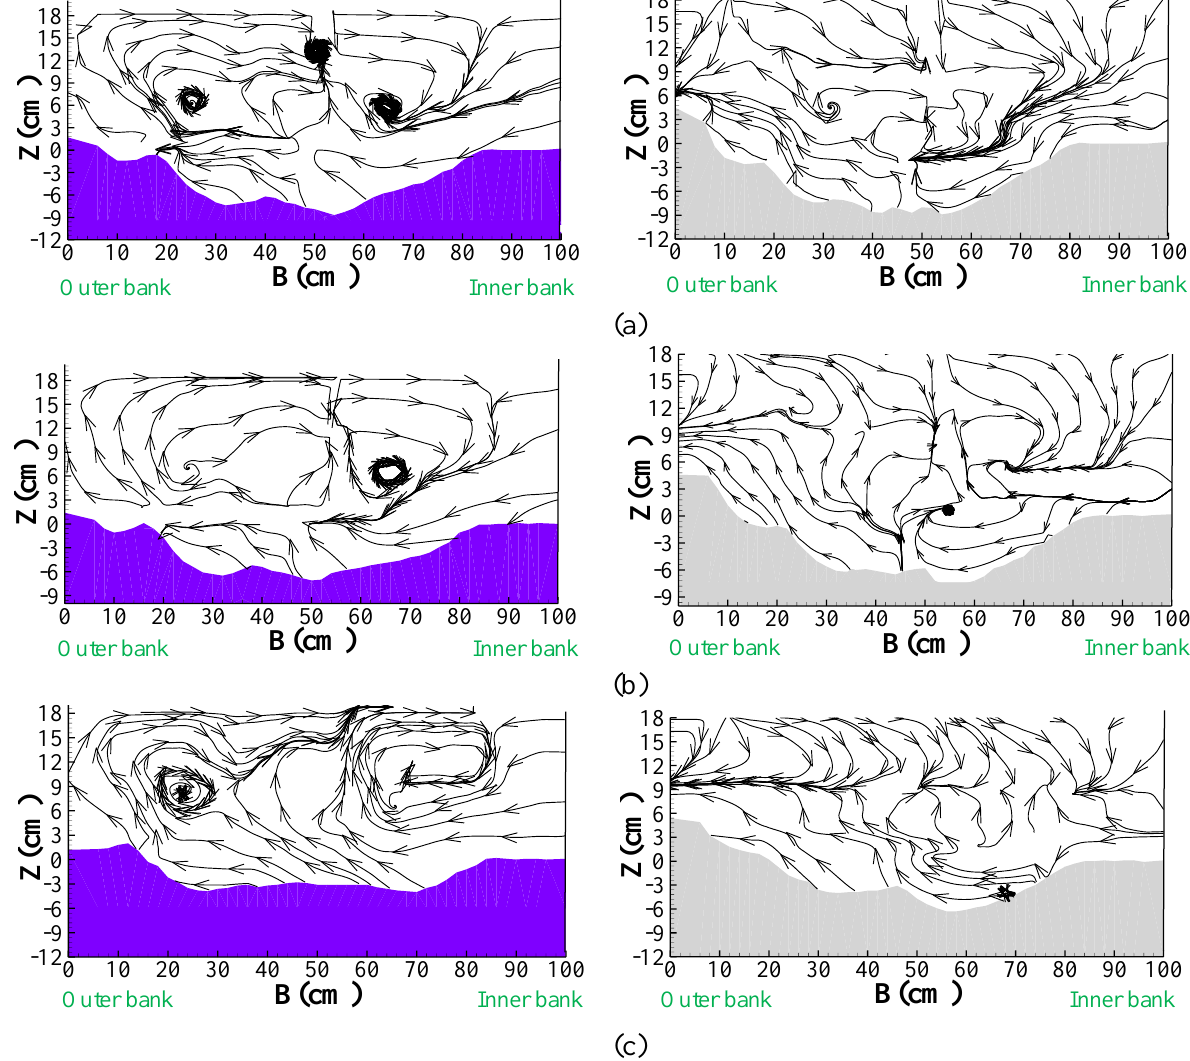
B ( c m Figure 5. A view of the flow pattern at the a) 92, b) 93.5, and c) 96 degree cross sections of the bend. (PFV experiment on the right, and PSV experiment on the left) Figure (6) represents cross sections at the end of the bend. In PFV case, such turbulence and vortices are still observed at a distance of 10 times the pier diameter in downstream direction (at the 100 degree angle from the beginning of the bend) in Figure (6-a). Whereas, in PSV experiment, turbulence occurs all the way to the end of the bend; thus, a small vortex is formed at the 140 degree angle in the middle of the channel (Figure (6-b)). As in Figure (6-c), in PSV experiment, the center of the main secondary flow occurs at a distance of 0 to 40% of the channel width from the inner bank at a height of 80% of the flow depth from the bed.